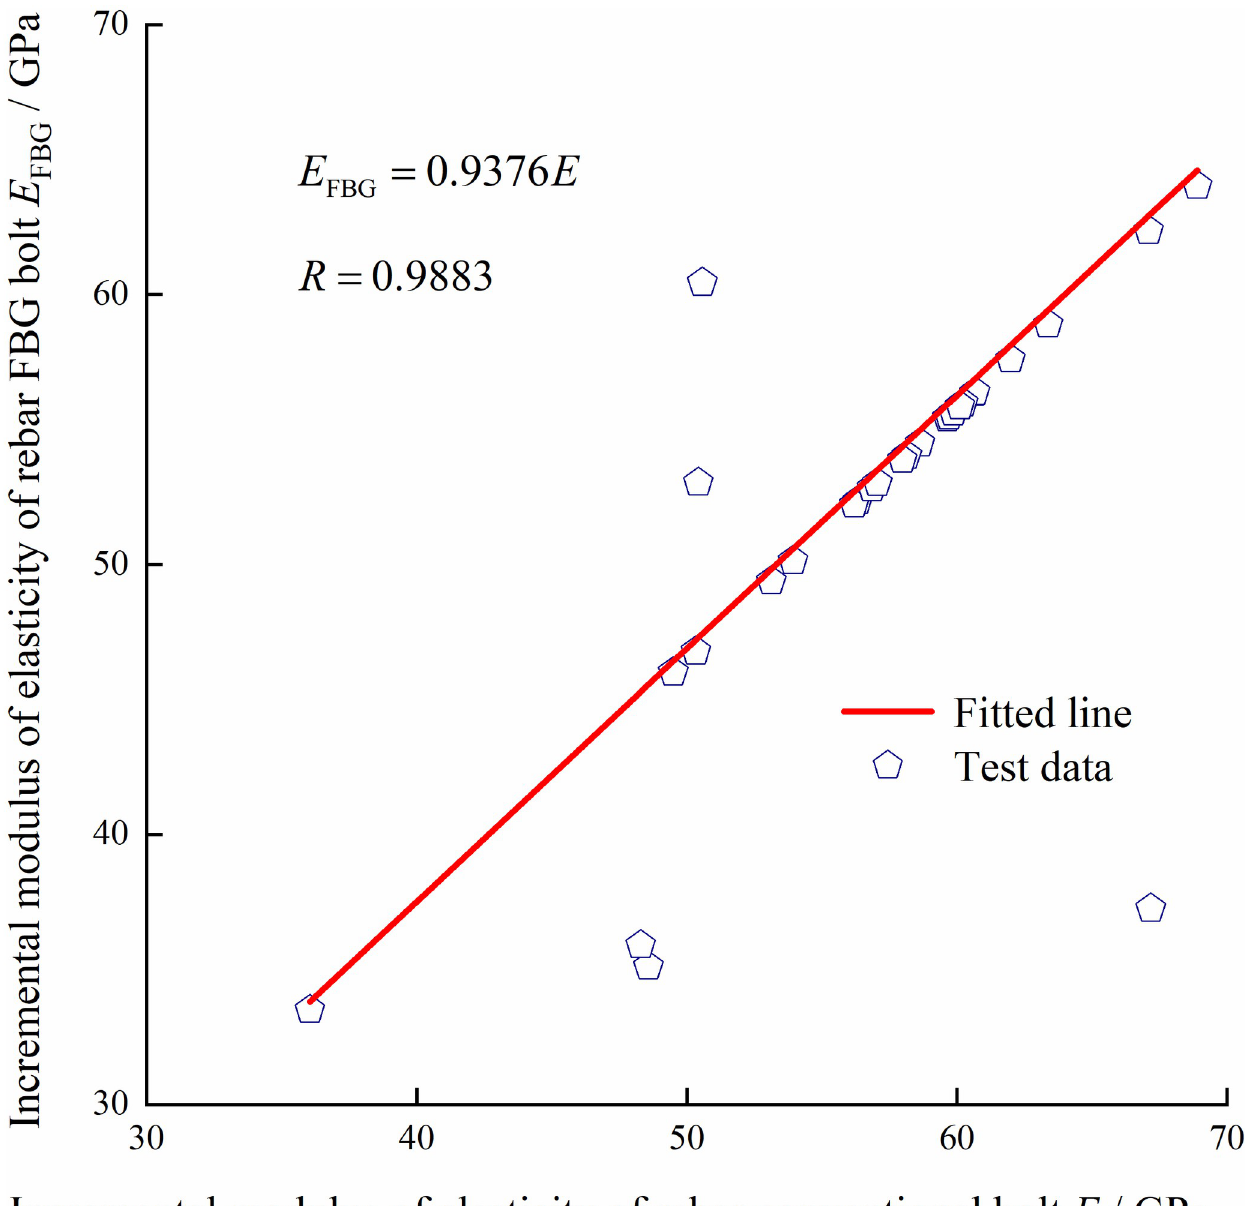
Fig 14. Rebar conventional bolt incremental elastic modulus relation curve.